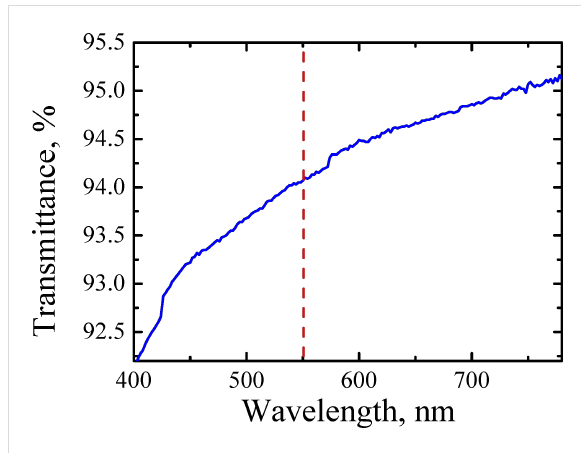
Figure 12: The transmittance of sample B versus wavelength on a glass substrate. The vertical dashed line indicates the wavelength at which the transmittance was